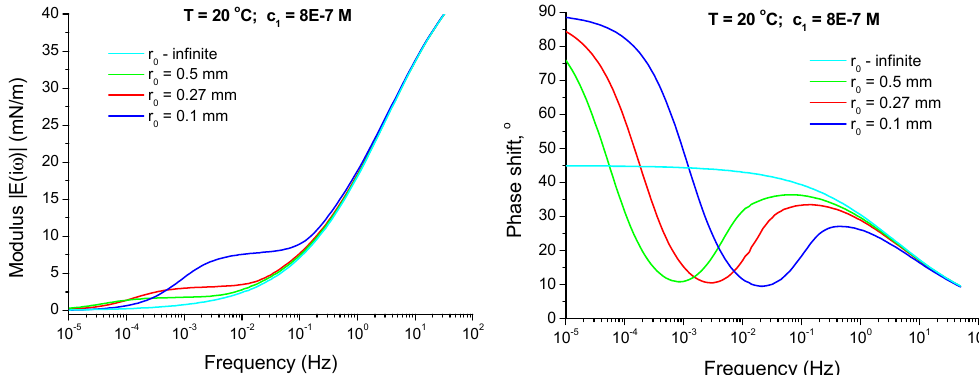
Figure 7. Viscoelasticity modulus | E ( i ω ) | and phase shift ϕ ( ω ) of C 13 DMPO adsorption layers at the drop interfaces with radii r 0 = 0.1, 0.27, 0.5 mm and infinite as functions of frequency, calculated according to Equation (14) for D α = D β = 10 − 9 m 2 /s and c α = 8.0 × 10 − 7 mol/dm 3 with the Langmuir isotherm parameters given in the text.